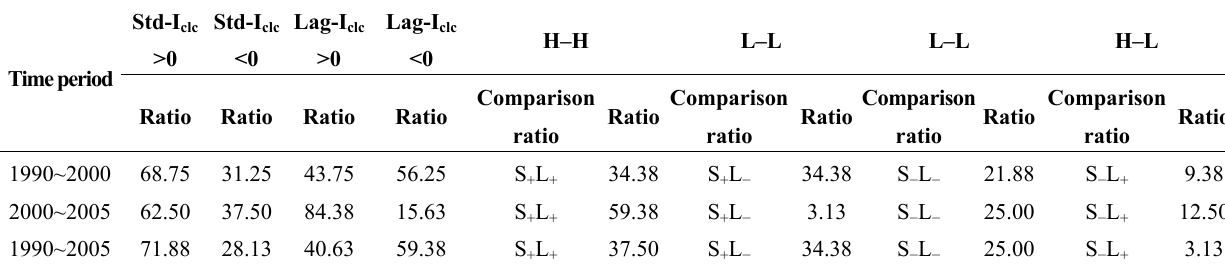
Table 4. Related parameters and disparity type of the standardized variable Z for ecological land change at the county level